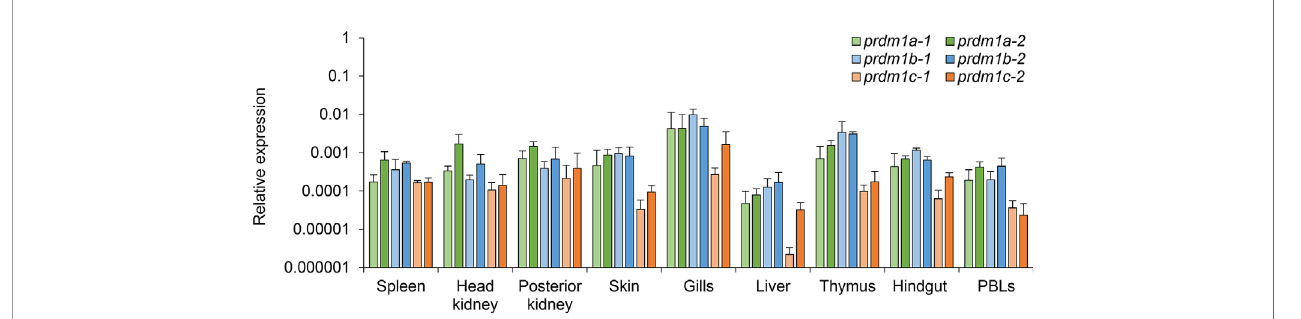
FIGURE 6 | Constitutive expression analysis of O. mykiss prdm1 genes. The levels of transcription of different prdm1 genes were analyzed in several tissues/cells obtained from healthy fi sh including the spleen, head kidney, posterior kidney, skin, gill, liver, thymus, hindgut, and PBLs. Gene expression data were normalized against the endogenous control ef-1 a and are shown as relative expression levels (means + SD; n